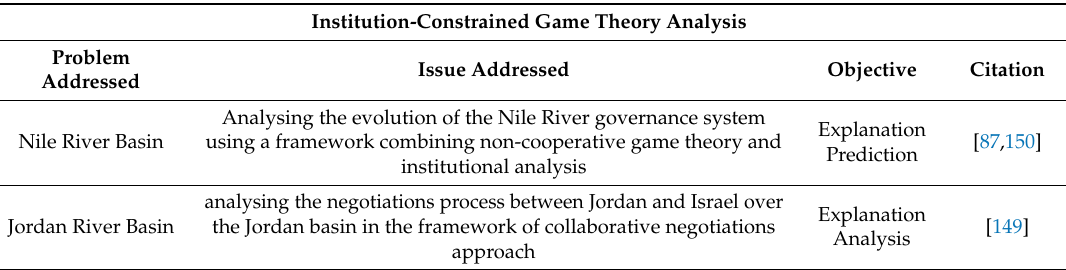
Table 6. Institution-constrained Game Mechanism—Theory and Implementation.